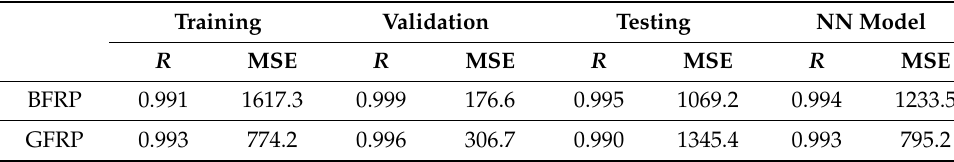
Figure 6. Regression plots for the relationship between the prediction and test values from the ANN results for the ( a ) BFRP and ( b ) GFRP predictive models. Table 5. Performance of ANN model for BFRP and